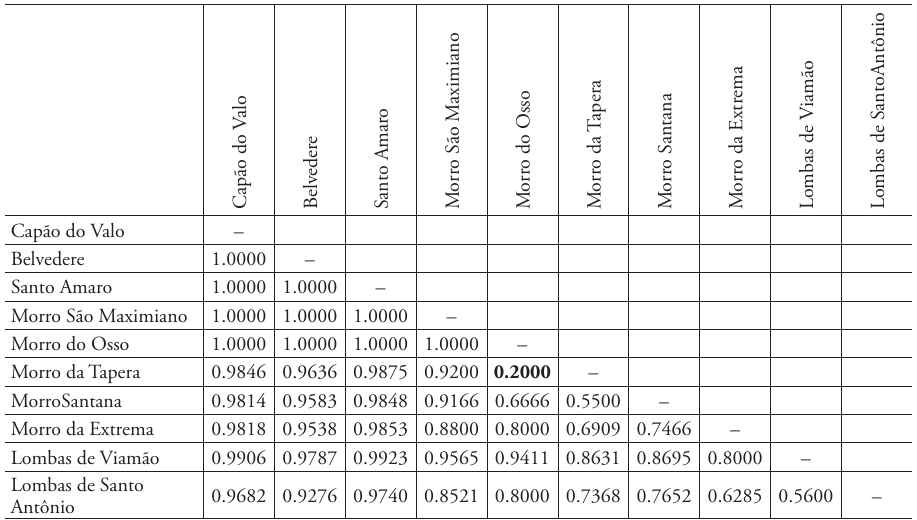
) for cytochrome oxidase subunit I ST